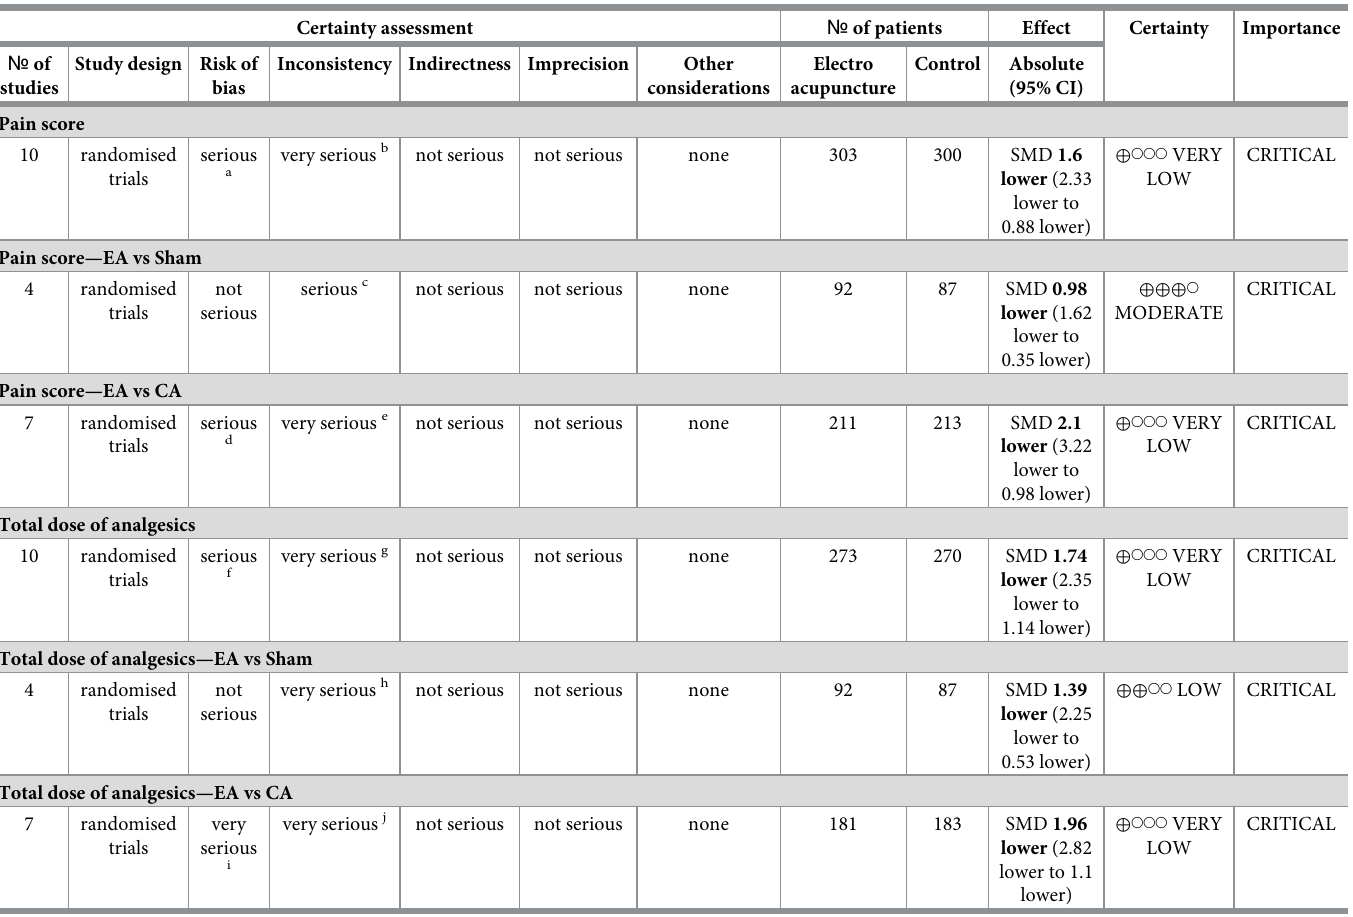
Table 3. GRADE evidence